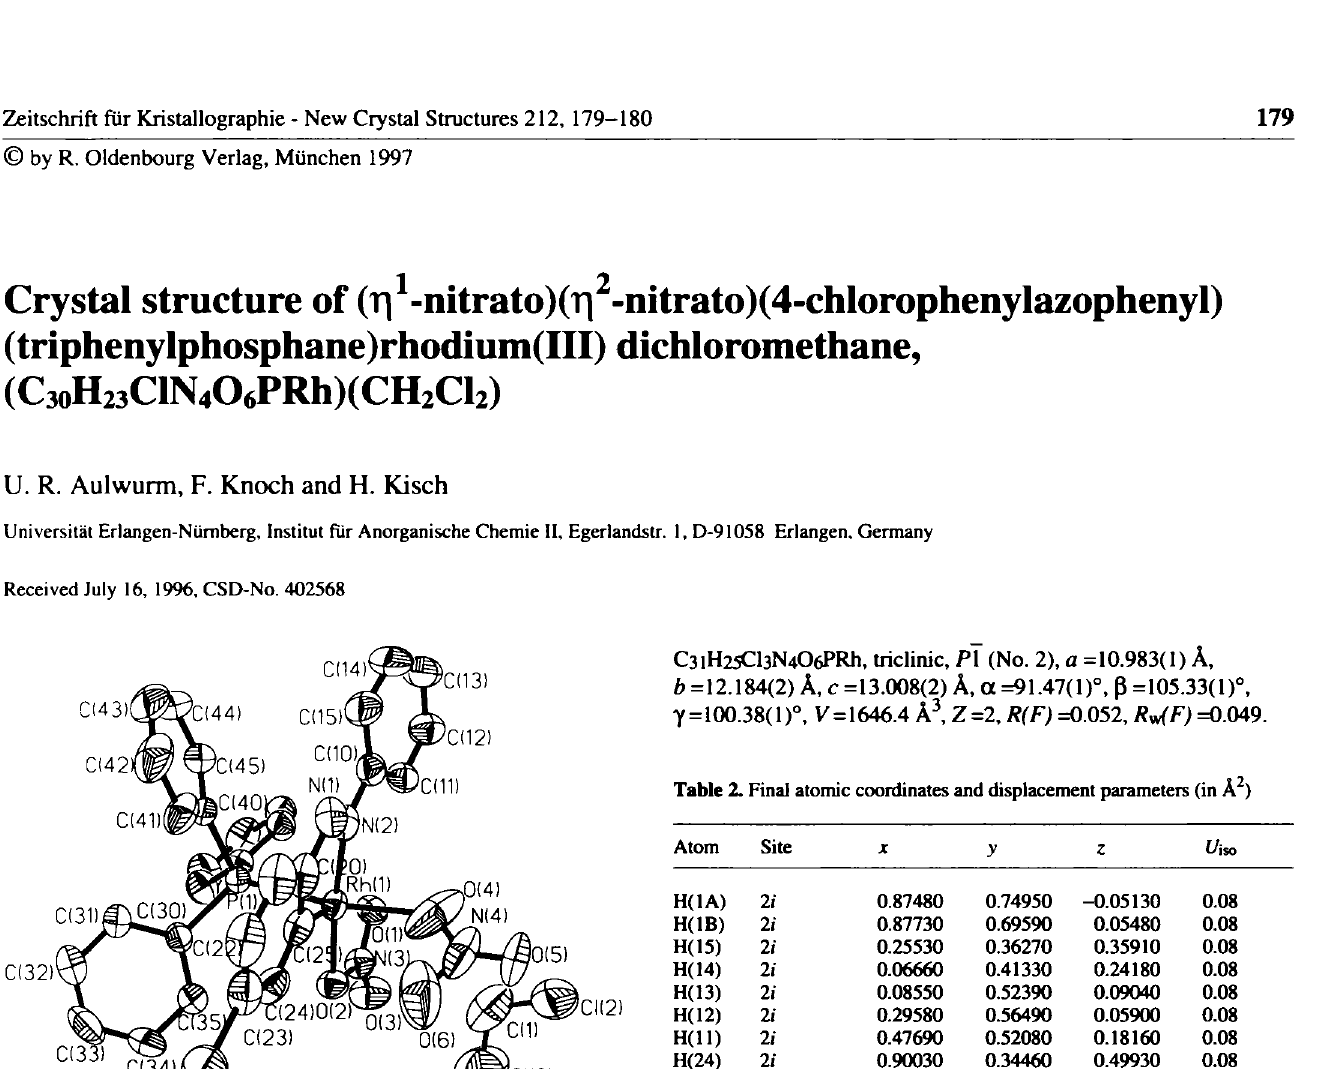
Table 1. Parameters used for the X-ray data collection Crystal: